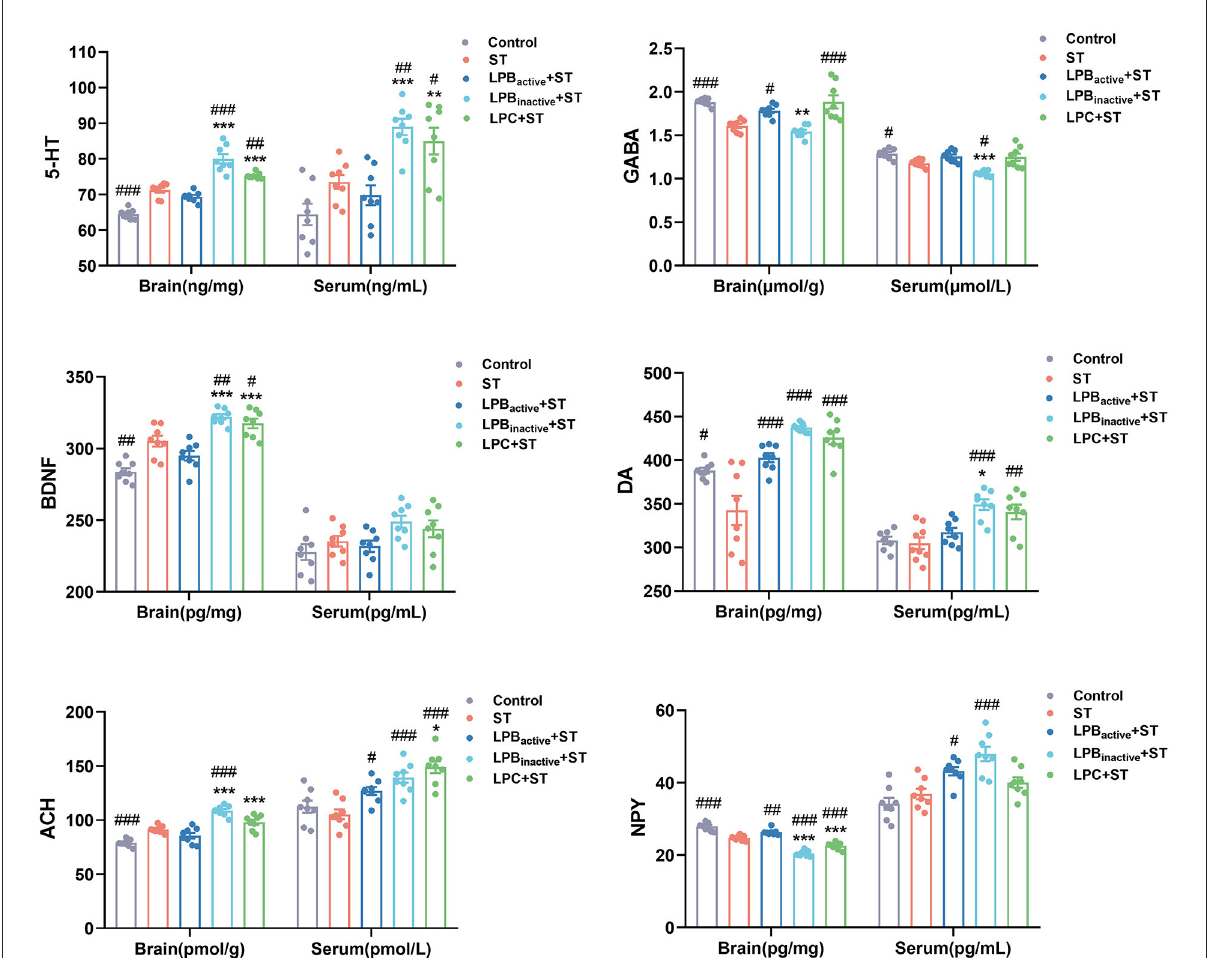
FIGURE8 The LP postbiotics modulate the levels of neuroactive molecules in mice. Concentrations of neuroactive molecules (5-HT, GABA, BDNF, DA, ACH, and NPY) in brain and serum. The data shown as mean ± SEM were analyzed by one-way ANOVA and Tukey’s test ( N = 8 in each group). # Indicates the significance compared to ST group: # p < 0.05, ## p < 0.01, ### p < 0.001. * Indicates the significance compared to LPB active + ST group: * p < 0.05, ** p < 0.01, *** p < 0.001.